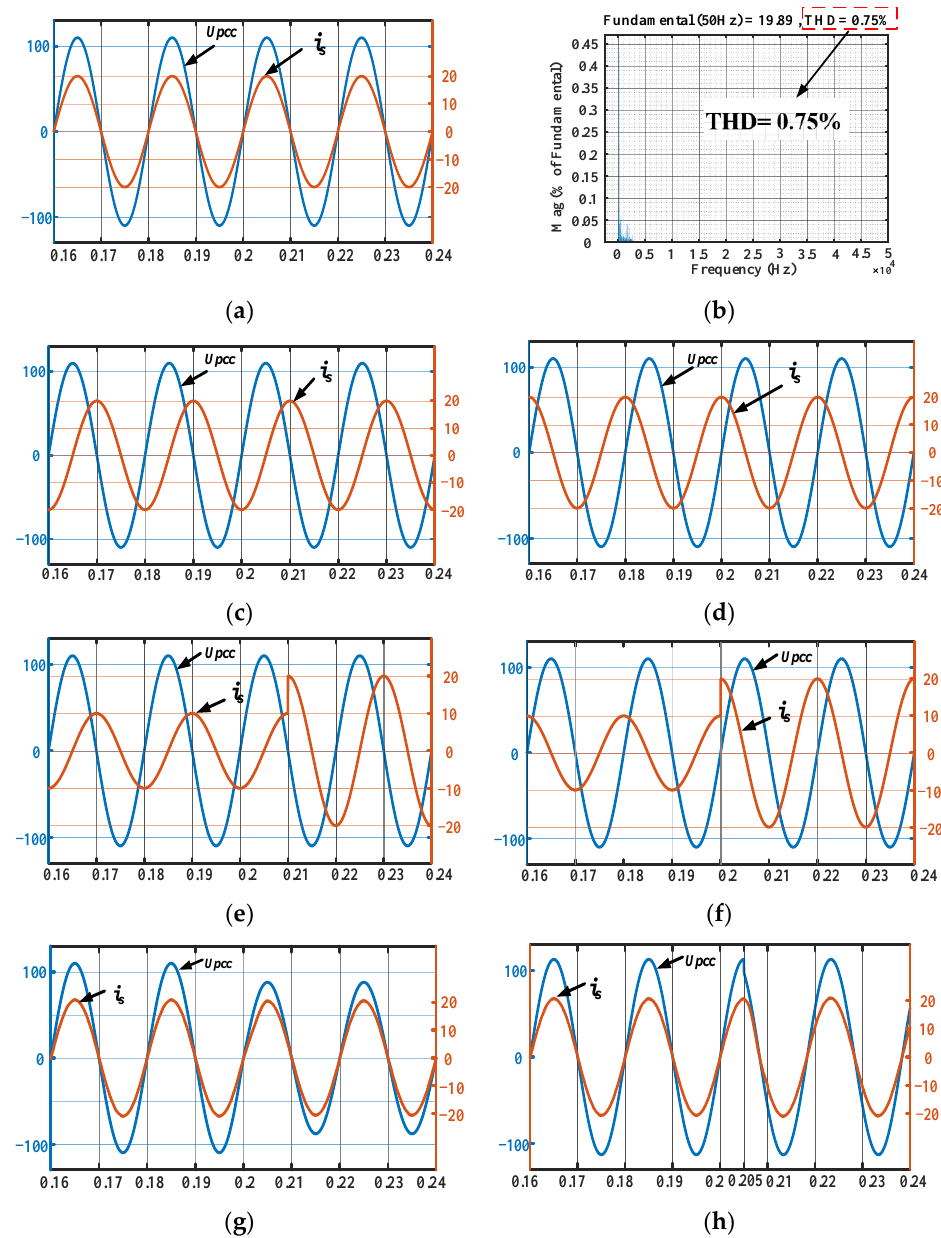
Figure 9. Waveforms of U PCC and i s . ( a ) Steady-state; ( b ) THD of grid current; ( c ) Inductive reactive current; ( d ) Capacitive reactive current; ( e ) Reactive current changes from 10 A to 20 A; ( f ) Reactive current changes from − 10 A to − 20 A; ( g ) U PCC suddenly dropping; ( h ) The phase of U PCC suddenly jumping (30 ◦